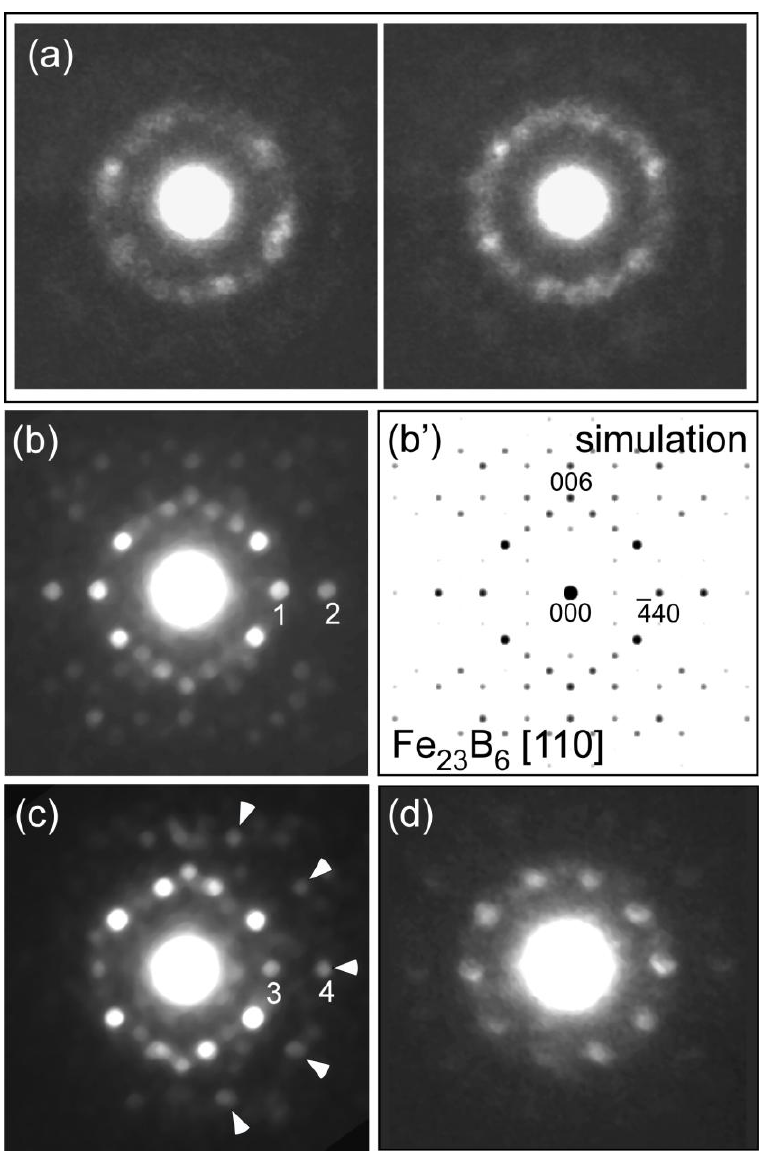
Figure 5. ( a ) NBED patterns obtained from as-quenched Fe NBED patterns obtained from Fe also shown in (b)-(d). ( b ) [110] pattern from a perfect Fe pseudo-tenfold pattern, and ( d ) almost tenfold pattern. The simulated [110] pattern of Fe B is also shown in ( b’ 23 6